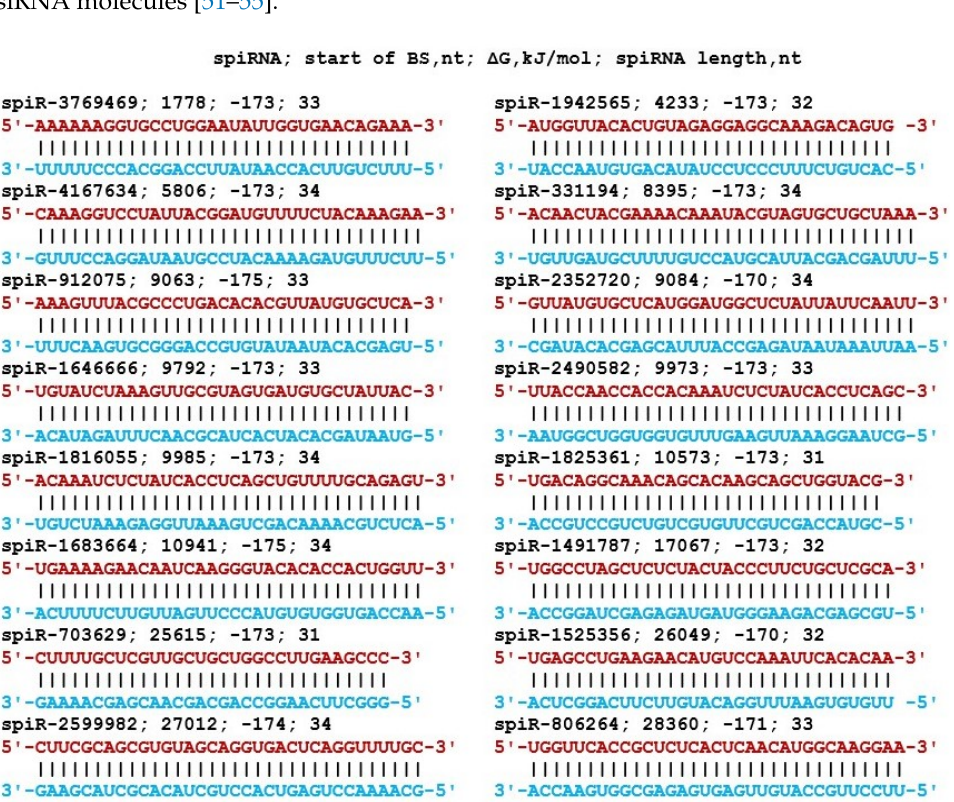
Figure 13. Nucleotide sequences of the 4 piRNA BSs cluster of gRNA from 29,280 nt to 29,308 nt and the nucleotide sequences of piRNAs. Note: The piRNA nucleotides that form canonical pairs with gRNA are highlighted in green and non-canonical pairs are highlighted in blue. The piRNA nucleotides that do not interact with gRNA are highlighted in red. The names of the piRNAs are followed by the beginning of their BSs.